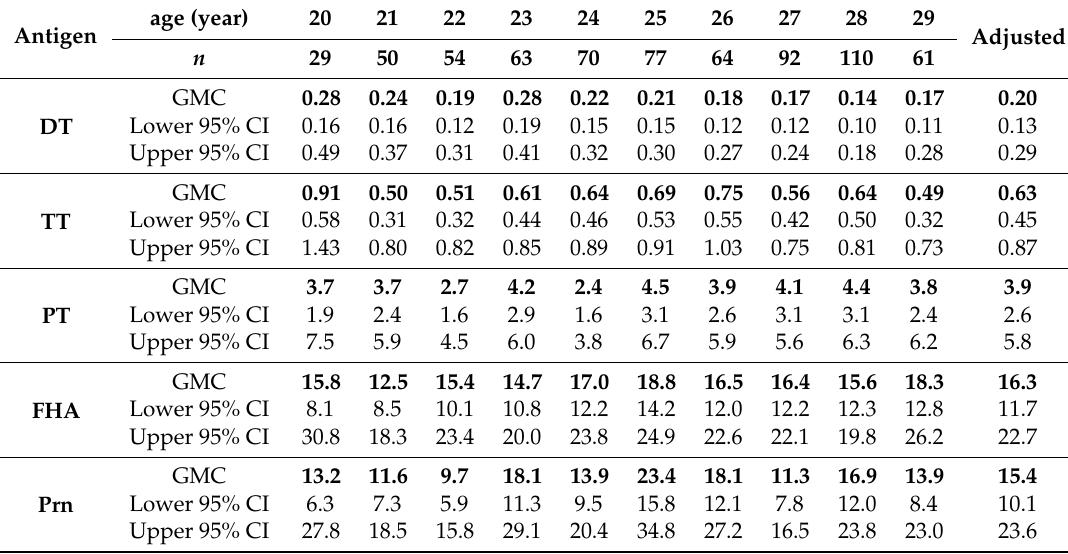
Table 2. Geometric mean concentration (GMC) of anti-DT, anti-TT, anti-PT, anti-FHA and anti-Prn IgG antibodies according to age.